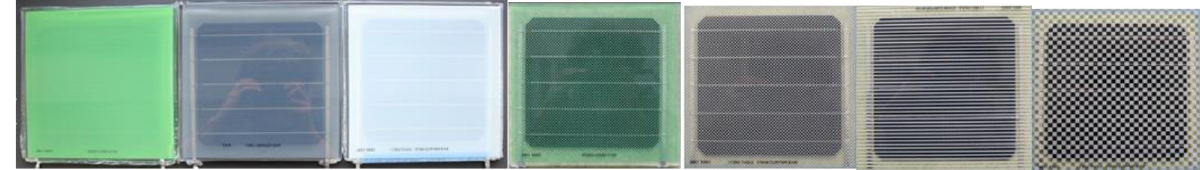
Fig. 4. The fabricated 1-cell modules/laminates with front glass coated with different colors (from left to right: grass green, squirrel grey, papyrus white, grass green dotted, papyrus white dotted, papyrus white linear and papyrus white squared).